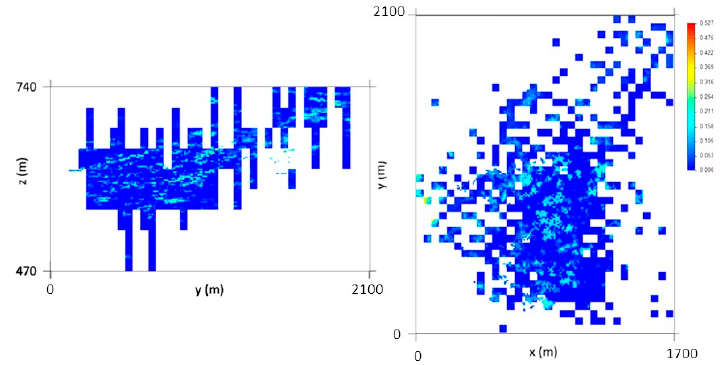
Figure 6. Direct Sequential Simulation (DSS) first-phase results after correction of averages: Px81 (left) and Pz75 (right). The diagrams show one of 1000 scenarios.